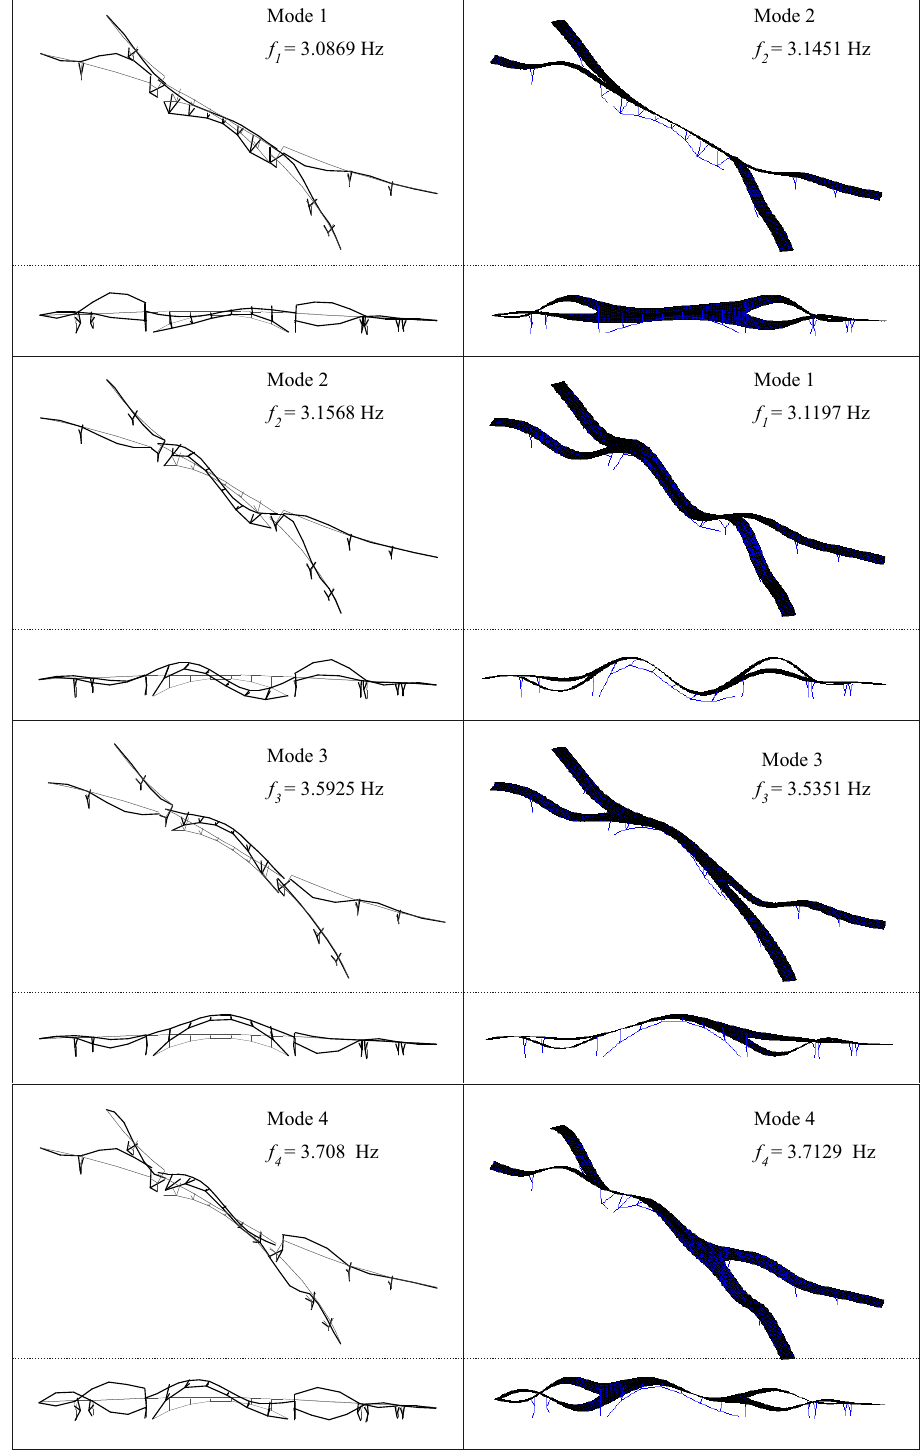
Figure 12. Mode shapes 1 to 4 of B ( left ) and S ( right )